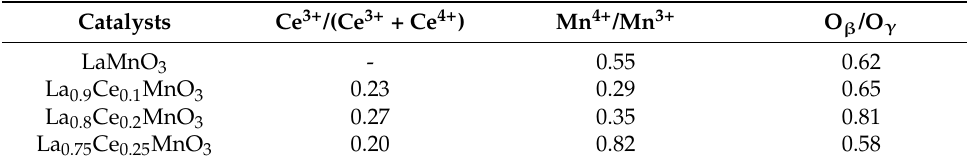
Table 2. Ratios of surface species of La 1- x Ce x MnO 3 obtained from XPS.